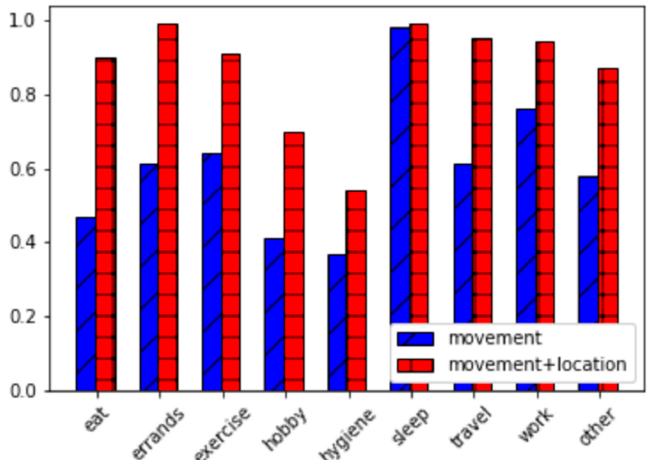
Figure 10. F-score activity recognition performance using only movement features and using movement combined with location features. Results are plotted for each activity category.